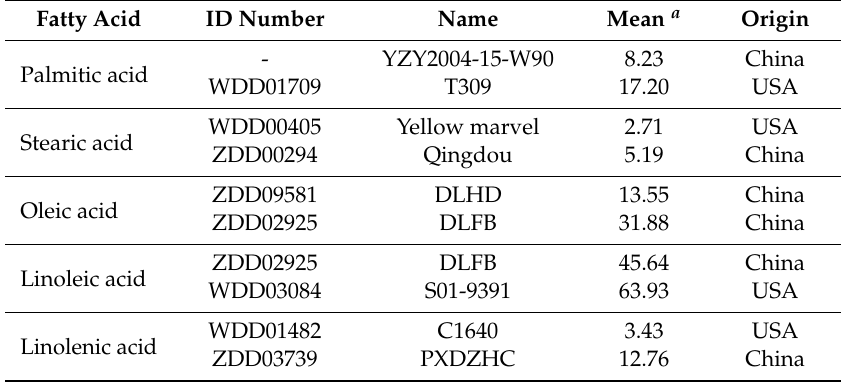
Table 2. Accessions with highest and lowest contents of five fatty